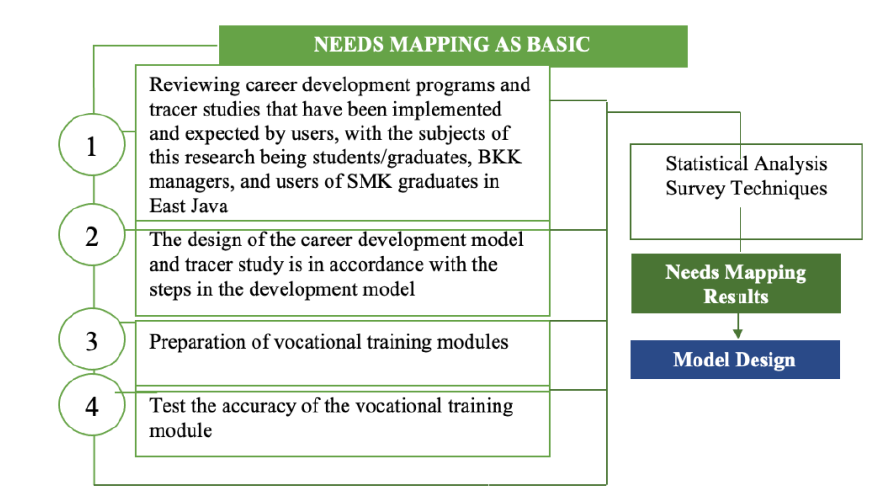
Figure 1: Procedure for Designing a Career Development Model and Tracer Study for Vocational High